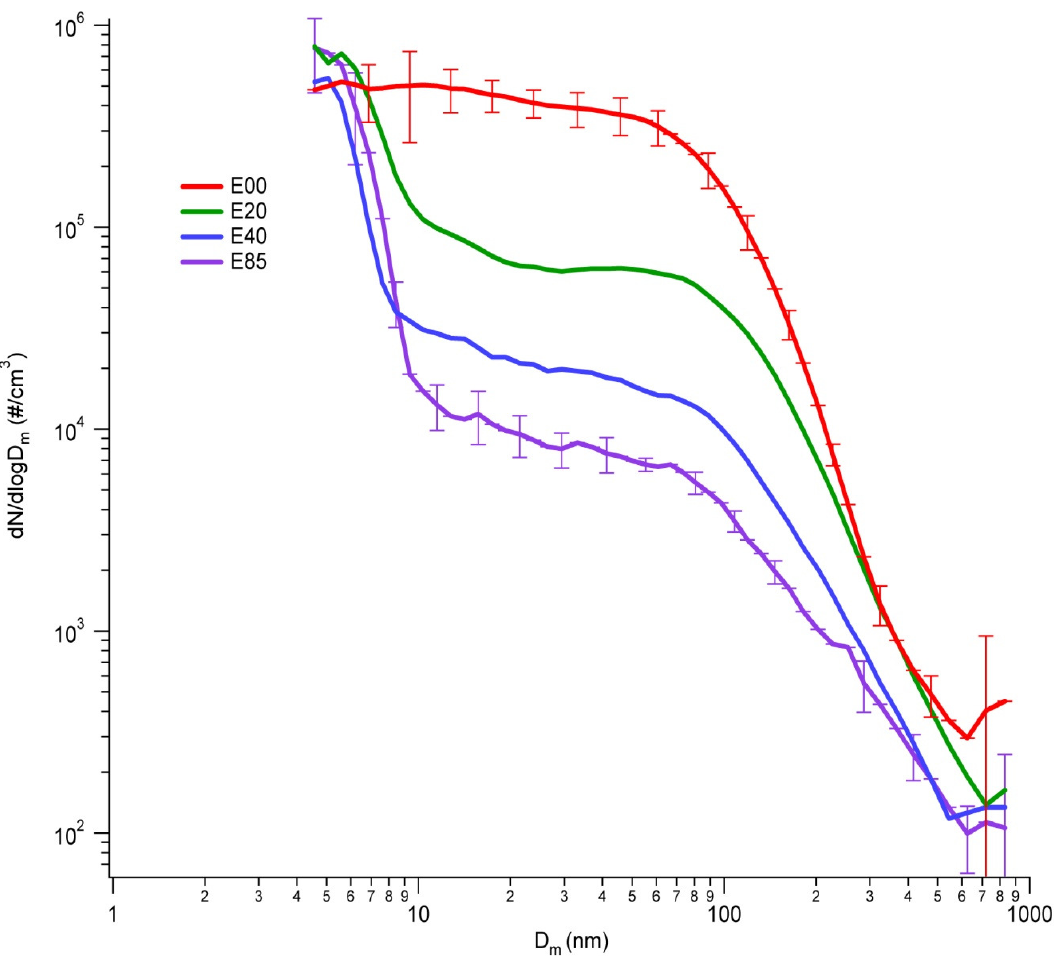
Figure 2. Particle mobility size (D ) distributions measured with the SMPS system m (~40 C) as a function of fuel ethanol content. Error bars (±1 standard deviation) were calculated based on repeated runs. Error bars are shown only for E00 and E85 fuels, for ease of visualization, and are of comparable magnitude for E20 and E40